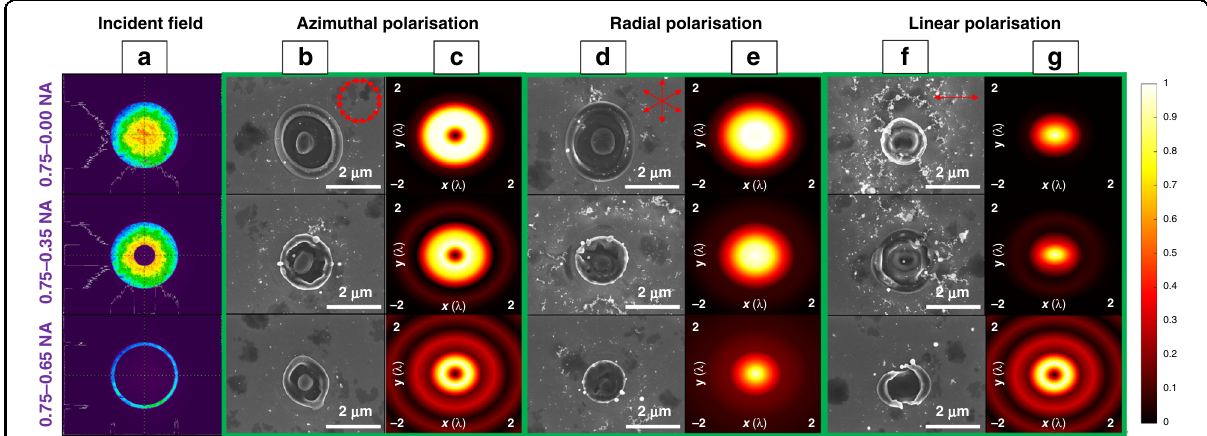
Fig. 1 Laser intensity pro fi les and material processing effects with a 0.75 NA objective lens. a Laser beam intensity pro fi le before the objective lens. The apodization function was set to be 0.75 – 0.00 NA (full aperture illumination, at the top), 0.75 – 0.35 NA (thick annular illumination, middle), and 0.75 – 0.65 NA (thin annular illumination, bottom). b , d , f Single pulse ablation on polished silicon with azimuthal, radial, and linear polarisation of laser beam under apodization function. c , e , g Corresponding modelled results of the beam intensity cross-section of the focused beam with azimuthal, radial, and linear polarisations under apodization function. The red symbols in b , d and f indicate the directions of E fi eld with different